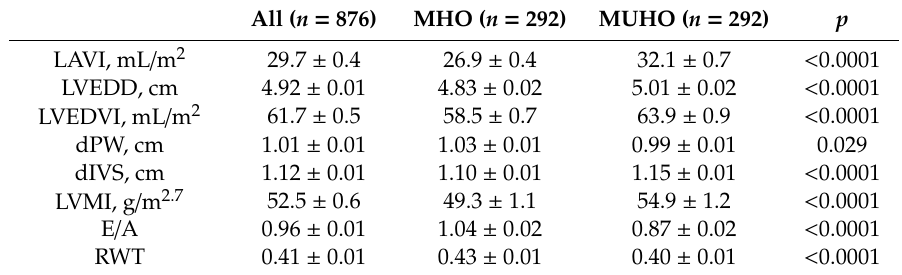
Table 2. Echocardiographic parameters of the whole study population and according to different obesity phenotypes.